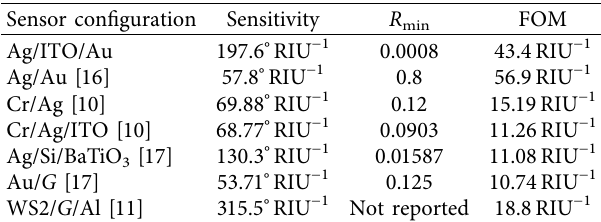
Table 3: Performance comparison of several reported